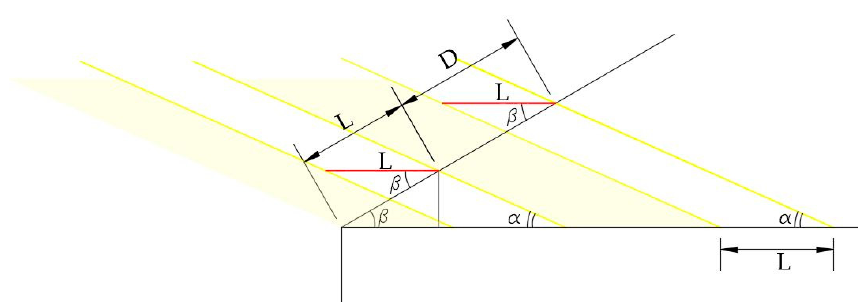
Figure 11. Parameters for calculating the distance D between the PV panels.